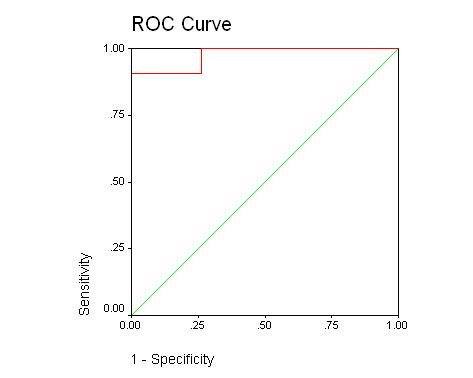
Receiver operating characteristics curve (ROC) of serum hyaluronate for discrimination of mild (stage 0–2) from significant (stage 3 or more) of fibrosis. Hyaluronate at cut off point of 126.43 ngm/ml could differentiate mild from severe fibrosis in patients with chronic hepatitis B.